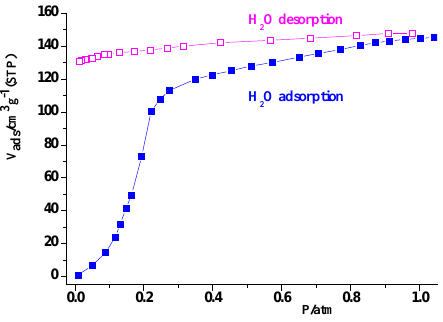
Figure 8. H 2 O adsorption isotherm at 298 K for 1′ : filled shape, adsorption; open shape,